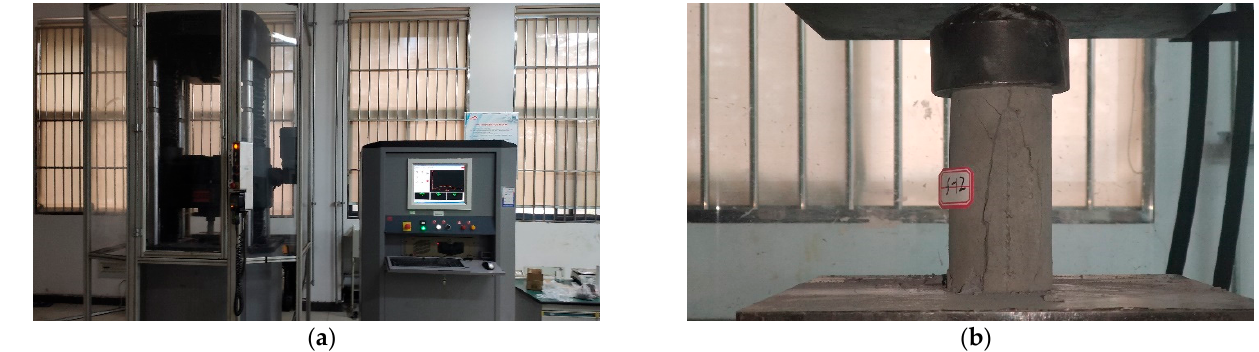
Figure 11. Loading system. ( a ) Experimental system, ( b ) uniaxial compression. Table 7. Strength and deformation characteristics of backfilling body samples with different Ce- ment/fly ash ratios.